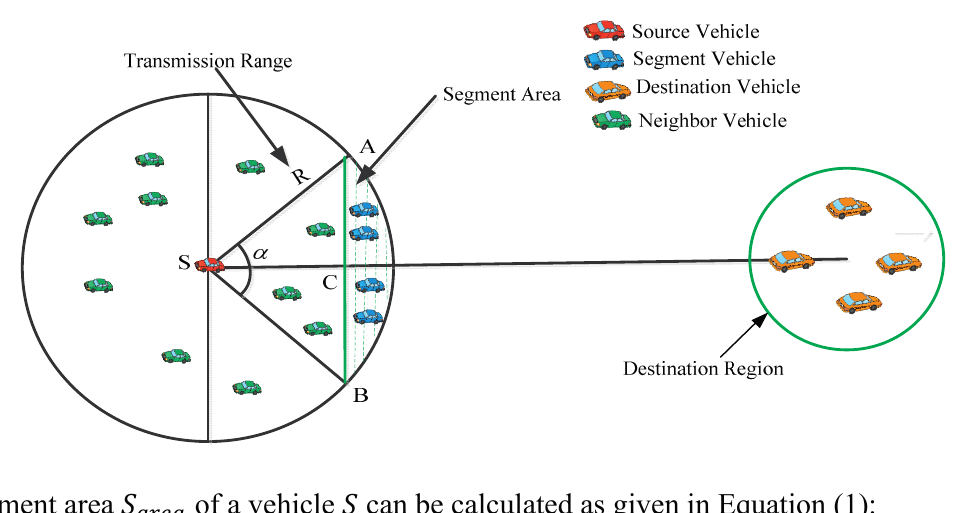
Figure 4. Segment vehicles and neighbor